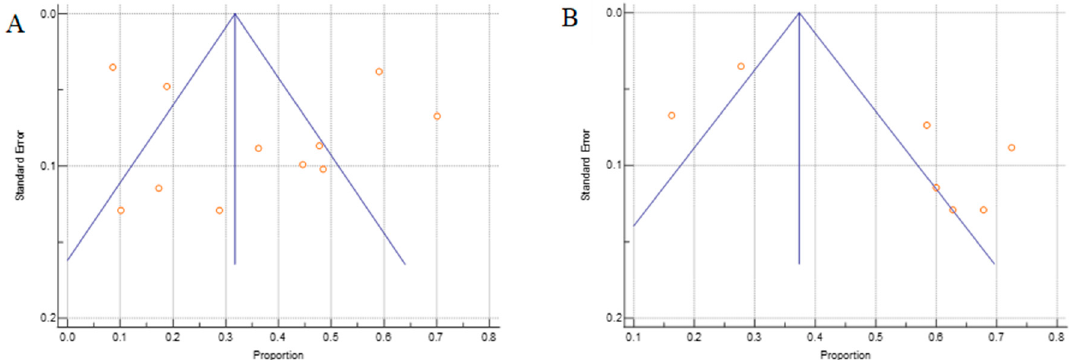
Figure 7. The Begg’s funnel plot of the PD-L1 proportion for the ( A ) TCs and ( B ) ICs. Side blue line indicates 95% confidence interval, middle blue line is the overall effect, and orange dots represent each individual study.